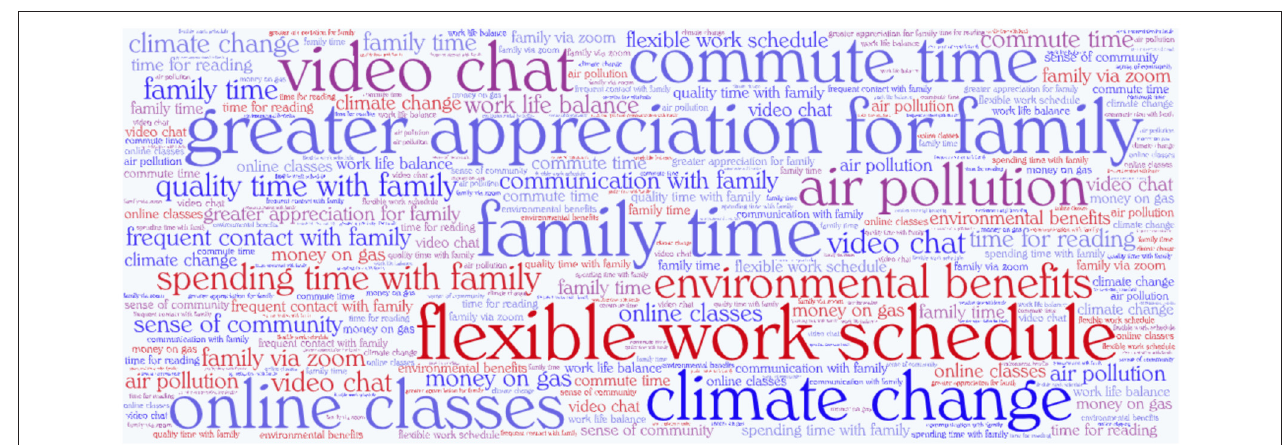
FIGURE 4 | Wordcloud of the most relevant terms (multi-word terms) extracted with BioTex from silver lining responses during the COVID-19 crisis between March and September